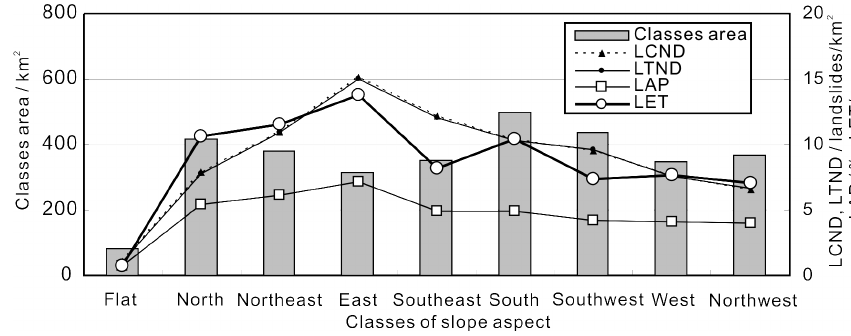
Figure 19. Relationships of co-seismic landslide abundance with slope aspects.